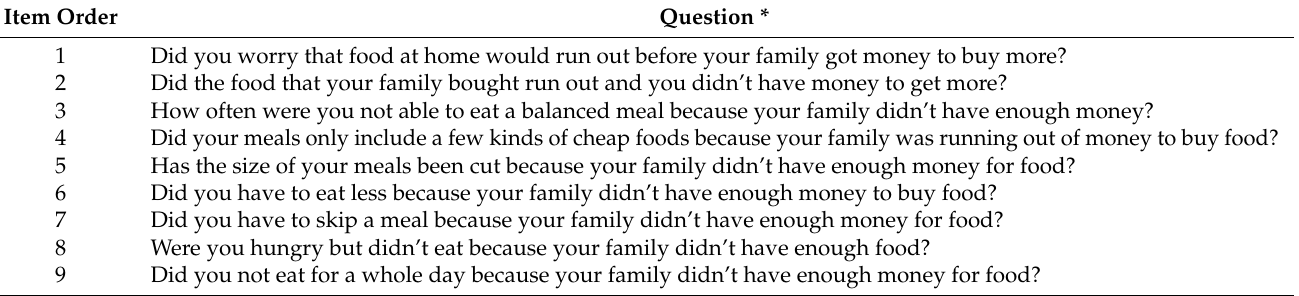
Table A1. Self-Administered Food Security Survey Module for Youth ages 12 and Older, created by Connell et al. (2004)